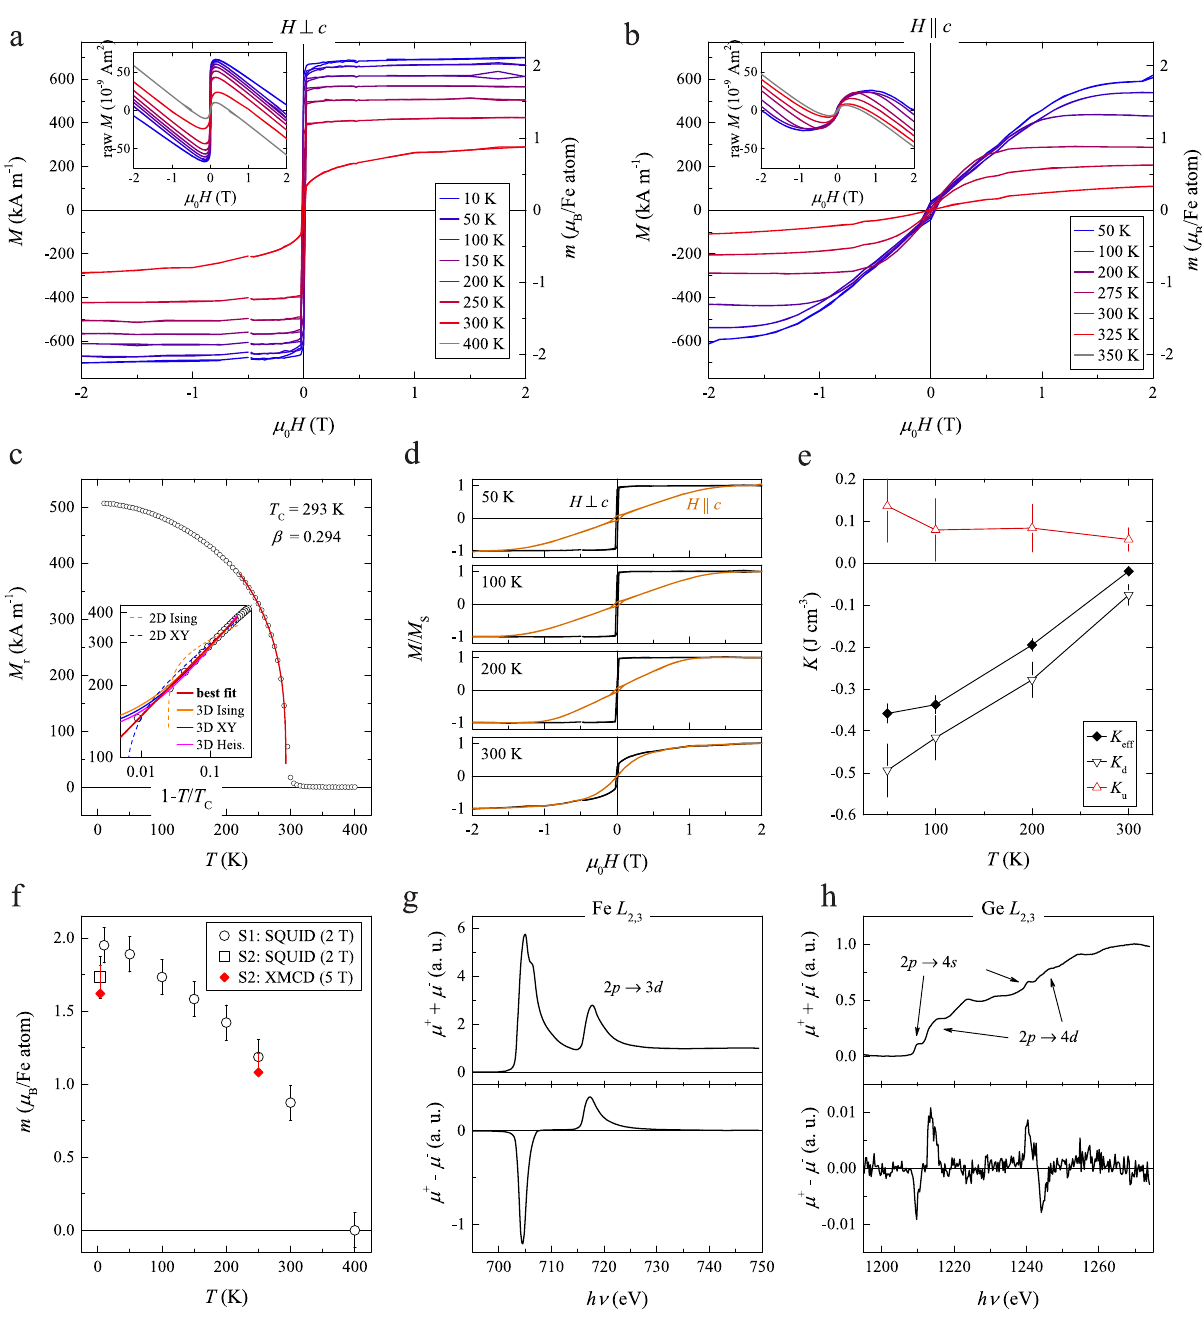
Fig. 4 Magnetic characterization of 12 nm-thick Fe 5 GeTe 2 using SQUID and XMCD. a Isothermal magnetic hysteresis loops with the external magnetic fi eld H in the ab basal plane for different temperatures. The magnetic background at temperatures well above T C has been subtracted for all measurements. Inset: Raw data highlighting the magnetic background considered. b Same as a , with H parallel to the c -axis. c Remanent magnetization as a function of temperature. Fitting to the scaling behavior of a magnetic system in an ordered state yields T C ≈ 293 K and β ≈ 0.294. The inset shows the scaling behavior of the remanence for different 2D and 3D magnetic critical exponents (see Supplementary Fig. 6). d Normalized in-plane and out-of-plane magnetic hysteresis loops for different temperatures. e Effective magnetic anisotropy, K eff , shape anisotropy, K d , and uniaxial anisotropy, K u , as a function of temperature. f Magnetic moment per Fe atom as a function of temperature determined from SQUID and XMCD for two 12 nm-thick samples (S1 and S2). g Normalized Fe L 2,3 -edge X-ray absorption spectroscopy (XAS) ( µ + + µ − ) and XMCD ( µ + − µ − ) spectra. µ + ( − ) is the absorption for parallel (antiparallel) alignment of the light helicity and the sample magnetization. h Normalized Ge L 2,3 -edge XAS and